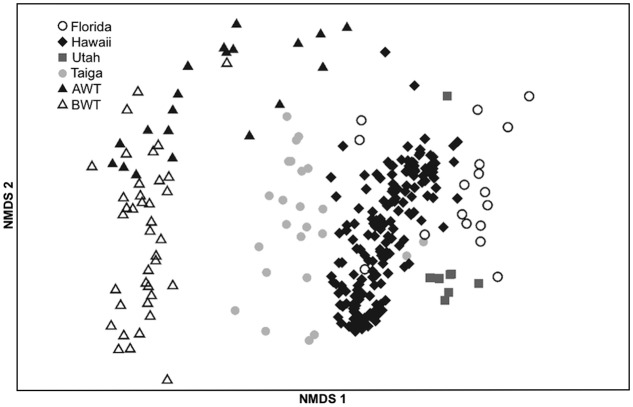
NMDS ordination of nifH harboring bacterial communities from this study (AWT = above water table, BWT = below water table) and those obtained from the NEON study (Wang et al., 2013) corresponding to samples taken in Florida, Hawaii, Utah and a Taiga forest. 2D stress = 0.12.